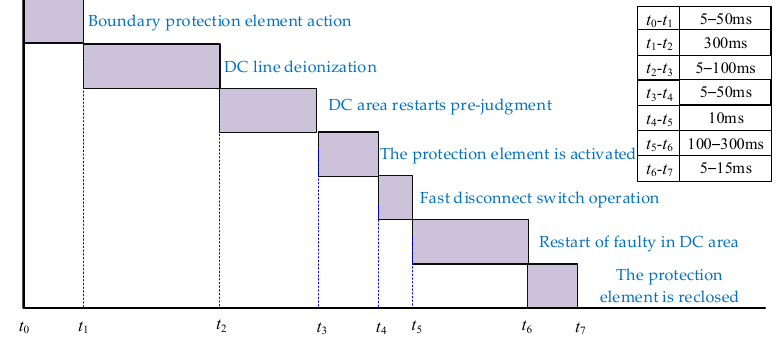
Figure 7. The overall protection coordination sequence of zonal ‐ based protection.